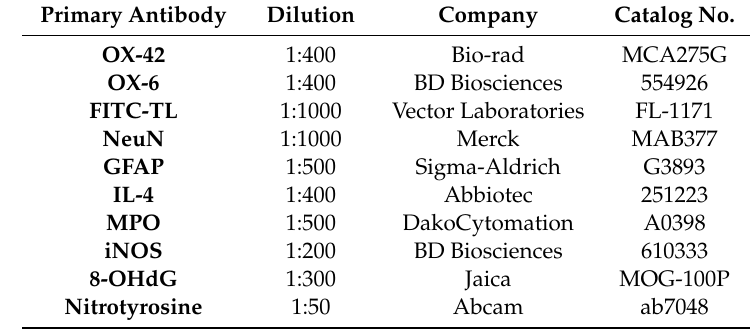
Table 1. Primary antibodies used for immunohistochemistry (IHC) and immunofluorescence (IF). Primary Antibody